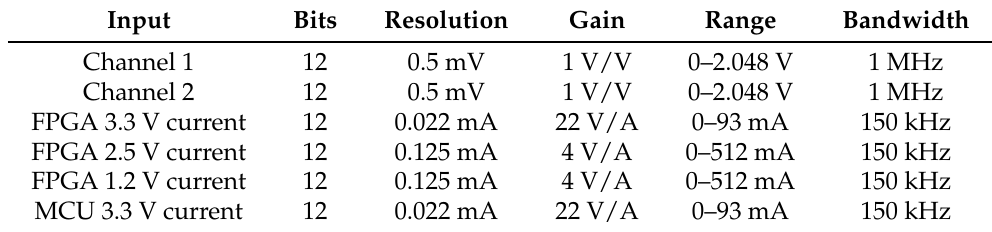
Table 1. Digital storage oscilloscope input